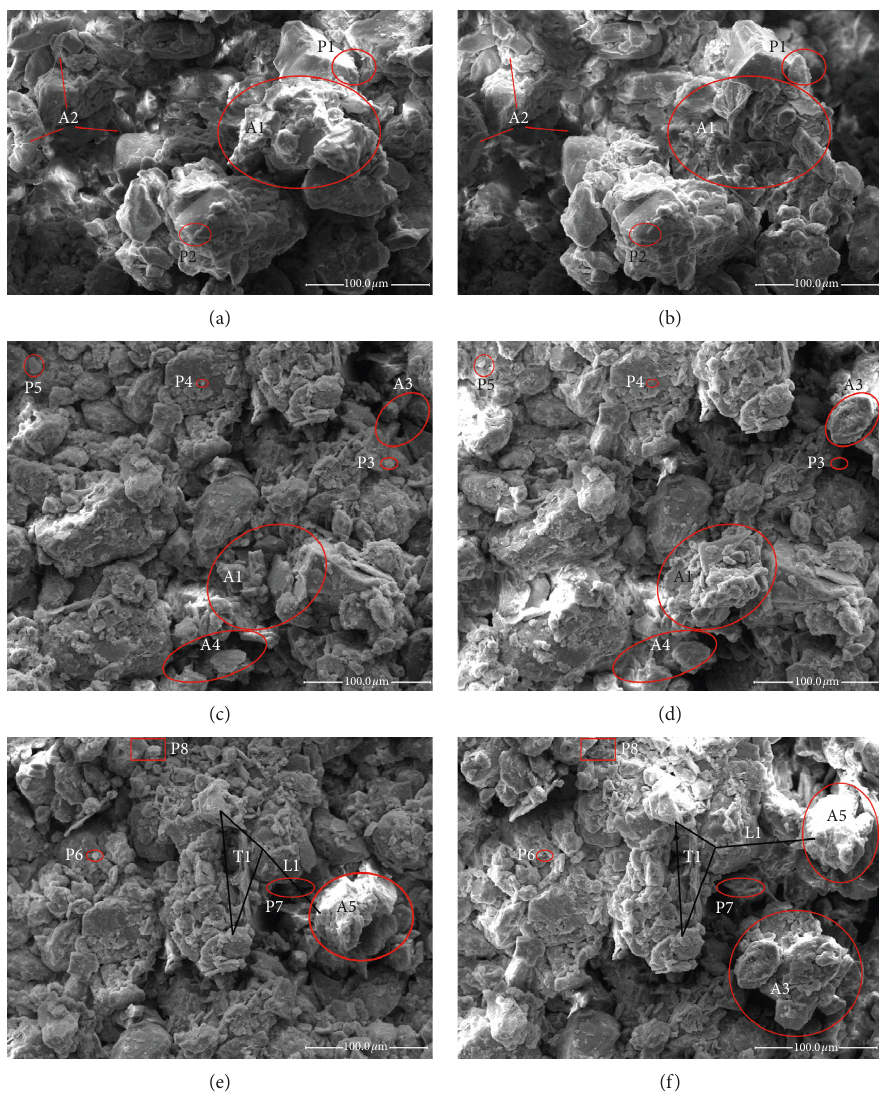
Figure 9: SEM images at the same positions before (a, c, e) and after (b, d, f)